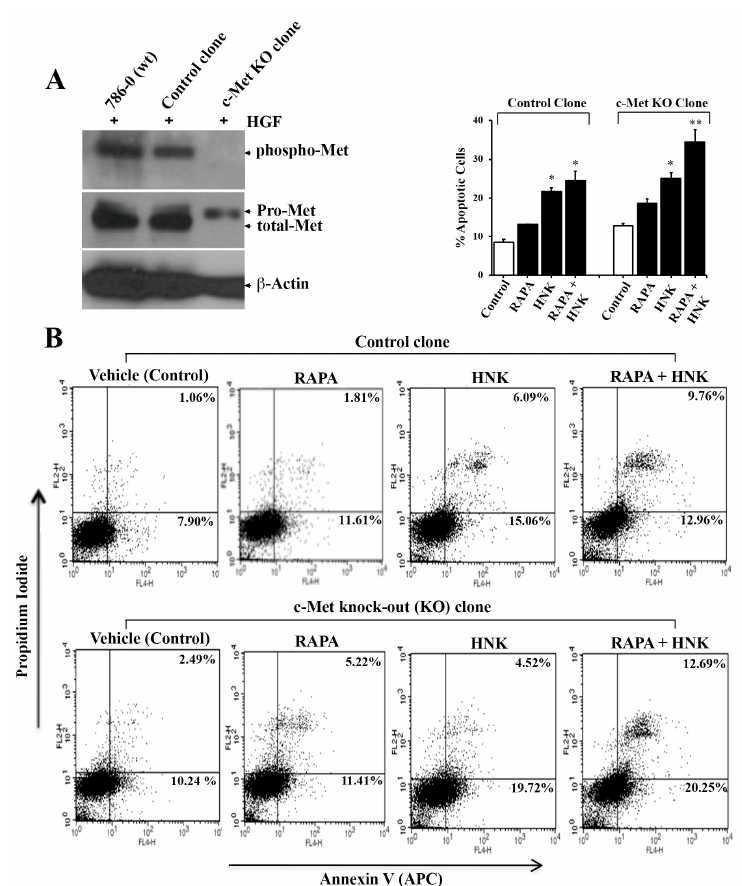
Figure 5. Enhanced apoptotic e ff ects of Honokiol (HNK) in c-Met knock-out renal cancer cells. ( A ) 786-0 (wild type), CRISPR / Cas9-mediated c-Met knocked-out clonal 786-0 cells (c-Met KO clone) and control clonal cells were treated with HGF (50 ng / mL) for 1 h. Following treatment, cell lysates were utilized and levels of phospho-Met (Tyr1234 / 1235), pro-Met / total-Met and β -actin were analyzed by Western blot. ( B ) Control and c-Met KO clones were treated with RAPA (15 µ M) and Honokiol (40 µ M) either alone or in combination and in the presence of HGF (50 ng / mL) or vehicle for 24 h. Following treatment, cells were stained with annexin V (APC) and propidium iodide and the apoptotic indices were analyzed by flow cytometry. ( A , B ), data shown are representative of three independent experiments; and the bar graph (above B , the FACS analysis) represents the percentage of total (early + late) apoptotic cells. The columns represent the mean ± S.D. of duplicate experimental readings. * p < 0.05 compared with respective controls; and ** p < 0.05 compared with RAPA- + HNK-treated cells in control clones. 2.6. The c-Met-Induced PD-L1 Expression on Renal Cancer Cells is Down-Regulated by RAPA and